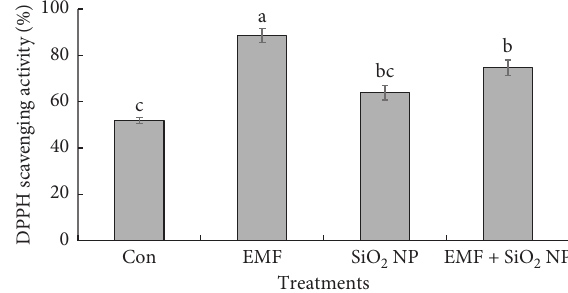
Figure 6: Impact of EMF and SiO 2 NP treatments on DPPH scavenging activity in A. gilanica plants. Bars indicate means ± SE ( n � 3) in each group. Different letters indicate significant differ- ences at P ≤ 0 .